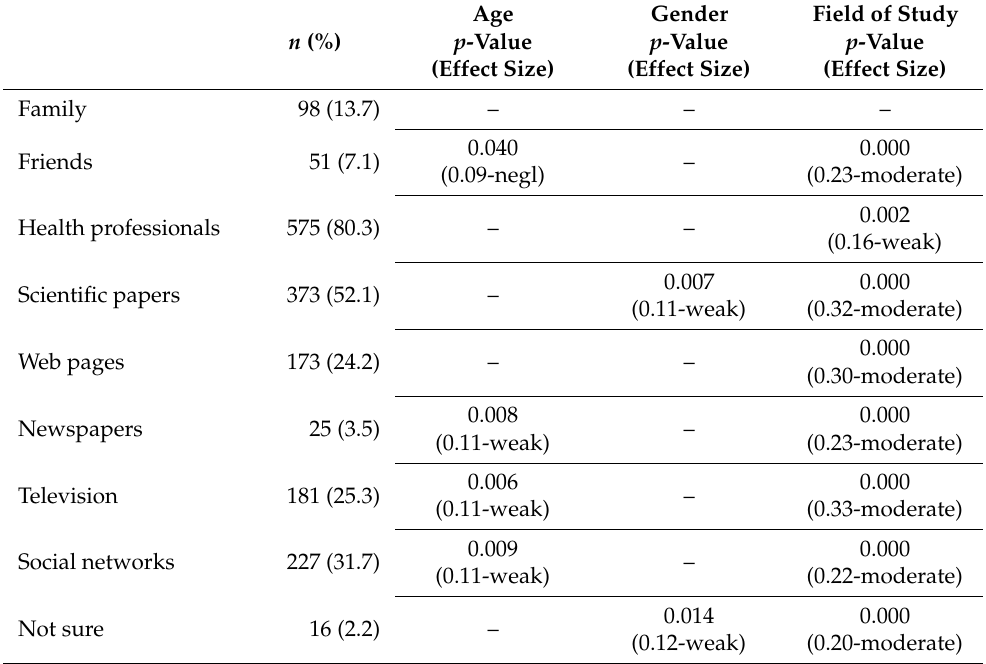
Table 4. Main sources of information about proper hand hygiene.